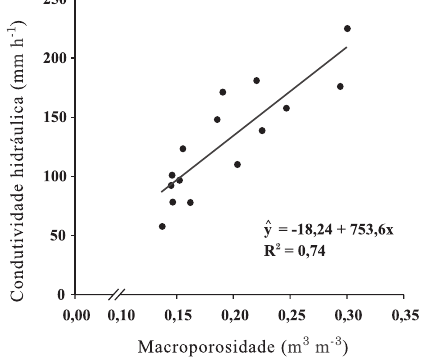
Figura 2. relação entre macroporosidade e condutividade hidráulica saturada de um latossolo Vermelho sob sistemas de culturas em plantio direto, considerando as camadas de 0–5, 5–10 e 10–20 cm. Figura 3. diâmetro médio ponderado úmido (dMpu)